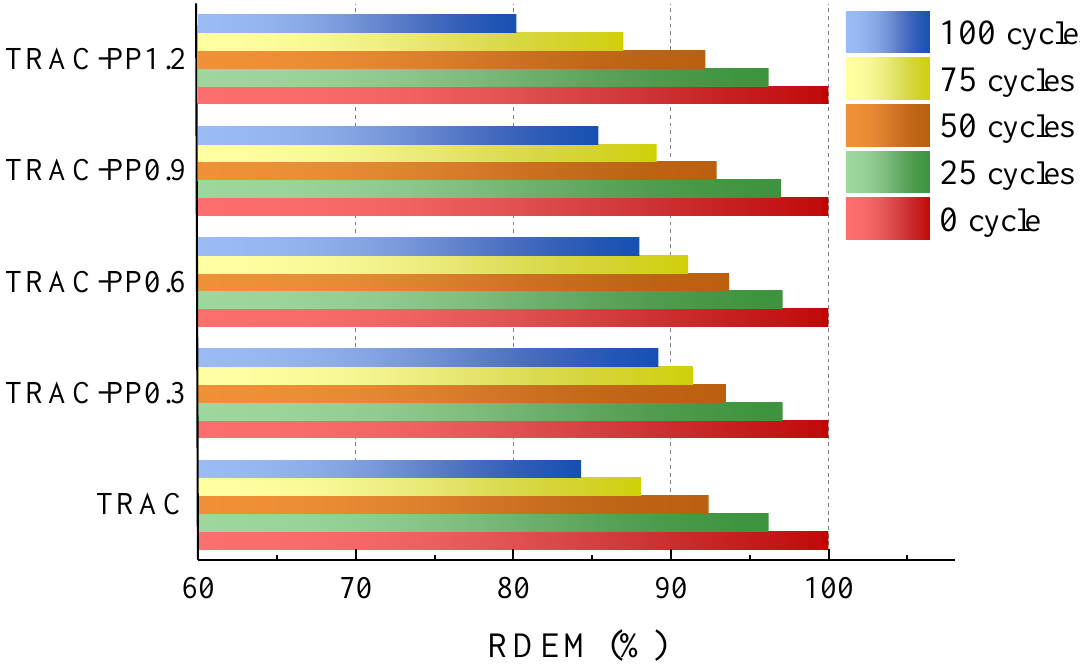
Figure 12. RDEM of all mixtures during freeze – thaw cycles.